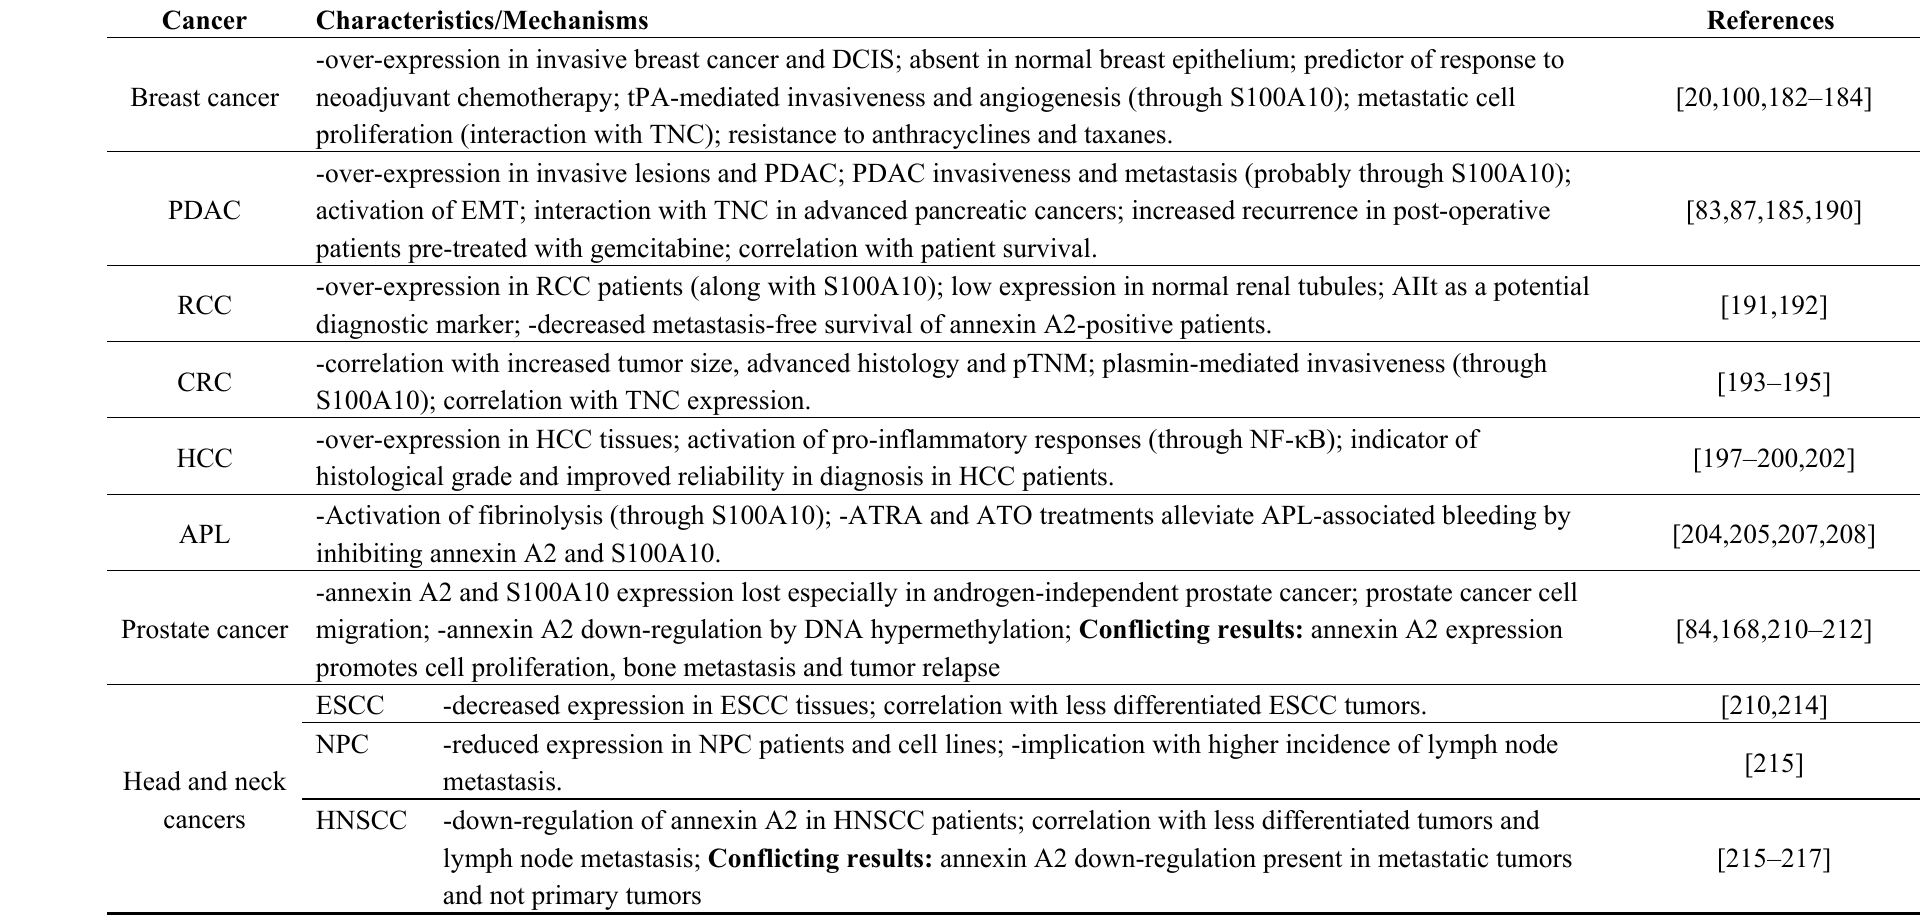
Table 1. Characteristics of annexin A2 deregulation in cancer and the potential mechanisms. The table summarizes the effects of annexin A2 deregulation in multiple cancers as discussed in the